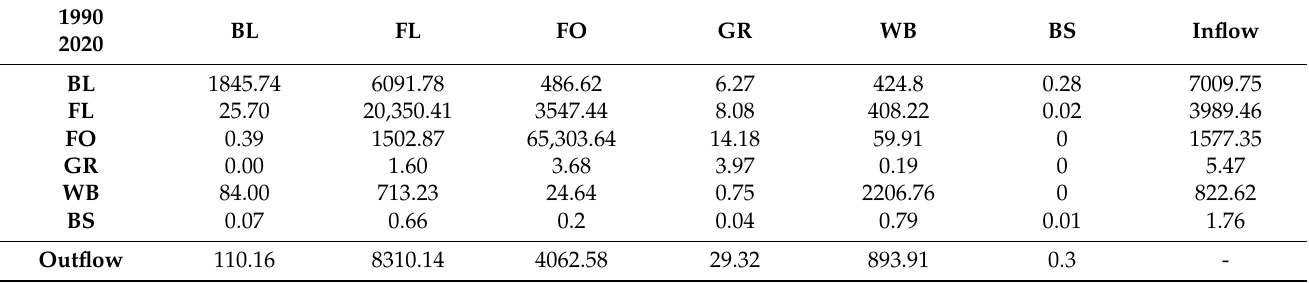
Table 3. Transfer matrix of land use change in Zhejiang Province from 1990 to 2020 (km 2